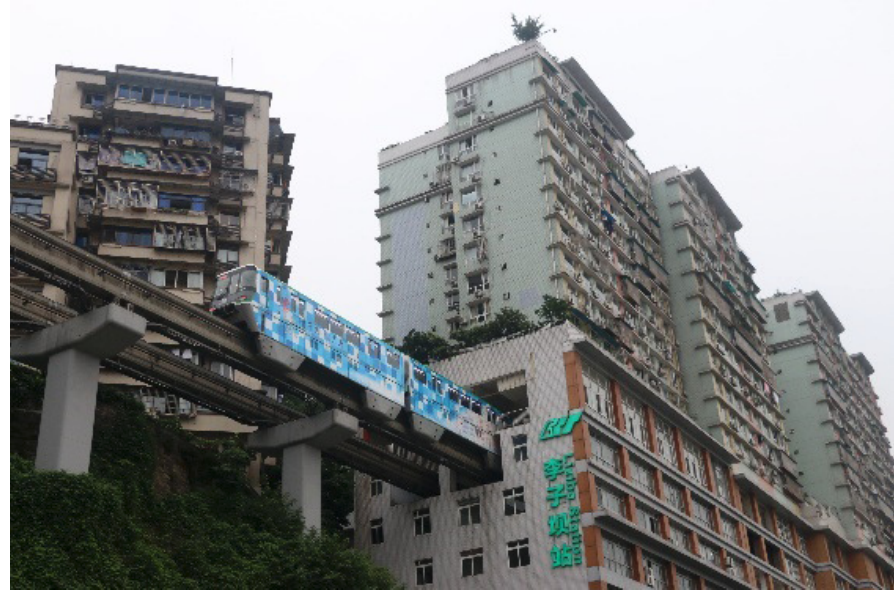
Figure 3. Liziba Station, with a train